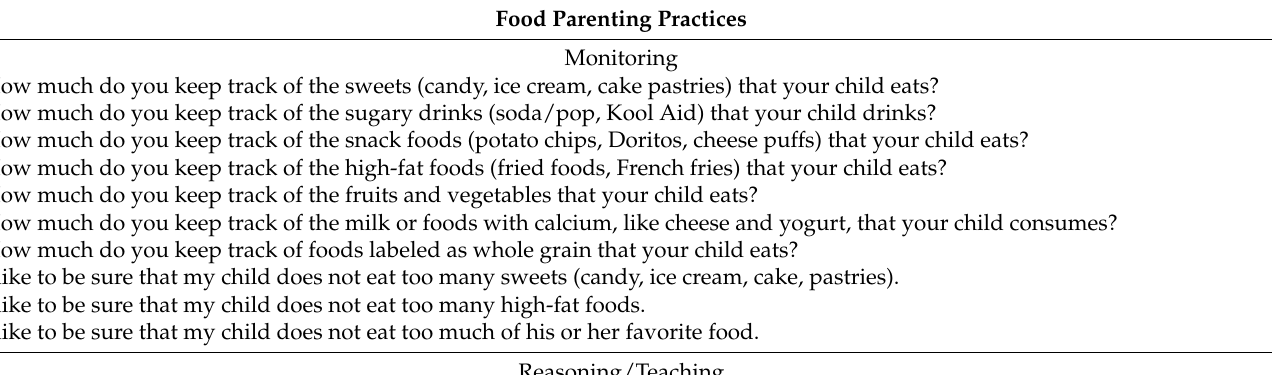
Table 3. Food parenting practices survey items. Food Parenting Practices